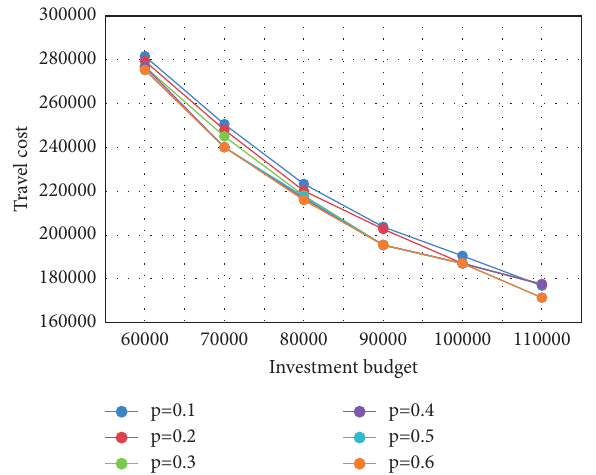
Figure 10: The changing procedure of travel costs according to B and p for Model